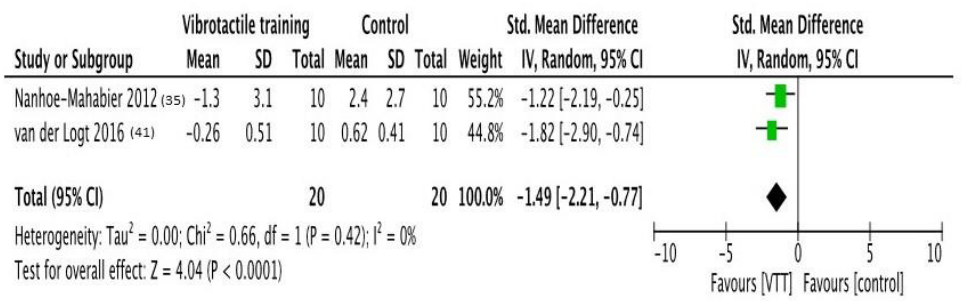
Figure 4. Forest plot of comparison: Overall effect of Vibrotactile feedback training in com- parison to no-feedback interventions. Outcome: roll sway angular velocity. Abbreviations: VTT, vibrotactile training; CI, confidence interval; SD, standard deviation [35,41,49]. 3.4. VF Effects on Roll Sway Angle Two RCTs [35,41] were included in this analysis, considering 20 subjects. Forest plot shows how both studies support the superiority of VTT in comparison to control treat- ments. The effect size is − 1.95 ( − 3.66; − 0.25) p = 0.02, and heterogeneity is substantial and significative (I2 = 77%; p = 0.04). The forest plot of comparison is shown in Figure 5. Figure 5. Forest plot of comparison: Overall effect of Vibrotactile feedback training in com- parison to no-feedback interventions. Outcome: roll sway angle. Abbreviations: VTT, vi- brotactile training; CI, confidence interval; SD, standard deviation [35,41].